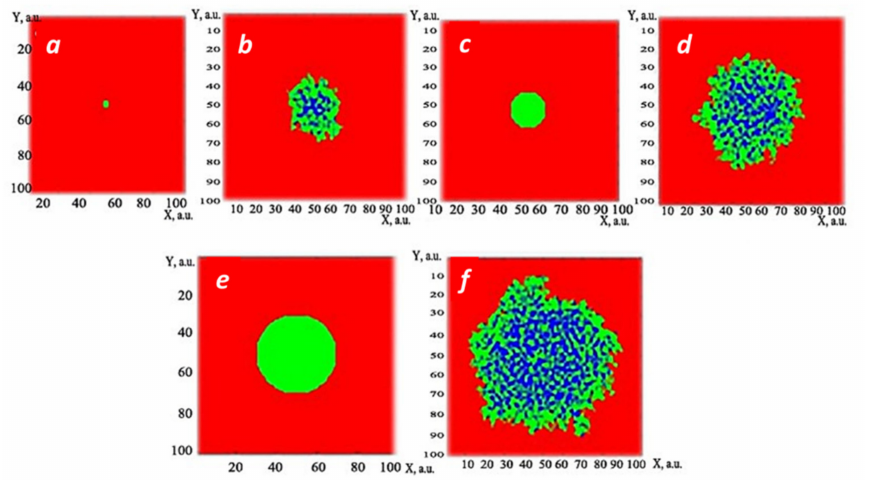
Figure 10. Seismic process propagation from a single isolated source (radius r). Initial conditions and solution–image for the propagation region of the studied state (in arbitrary units): ( a ) initial conditions r = 2, T = 4; ( b ) corresponding solution, but already for T = 100; ( c ) initial conditions r = 10, T = 4; ( d ) decision, but for T = 100; ( e ) initial conditions r = 20; T = 4; ( f ) decision, but for T = 100, where T is also the relative number of steps in time and specifies the partition on the uniform grid with step